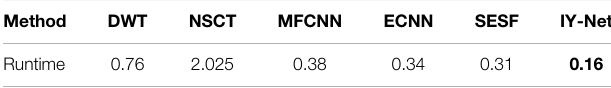
TABLE 6 | Average running time of various algorithms (Time unit: second).